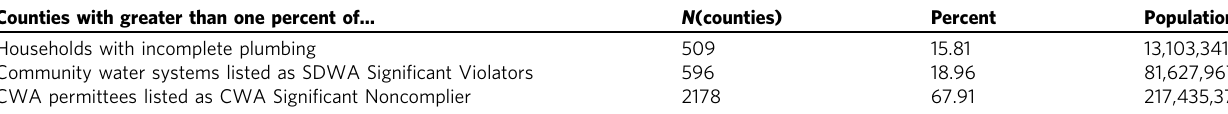
Table 2 Estimates of elevated levels of water hardship in the United States. Counties with greater than one percent of …